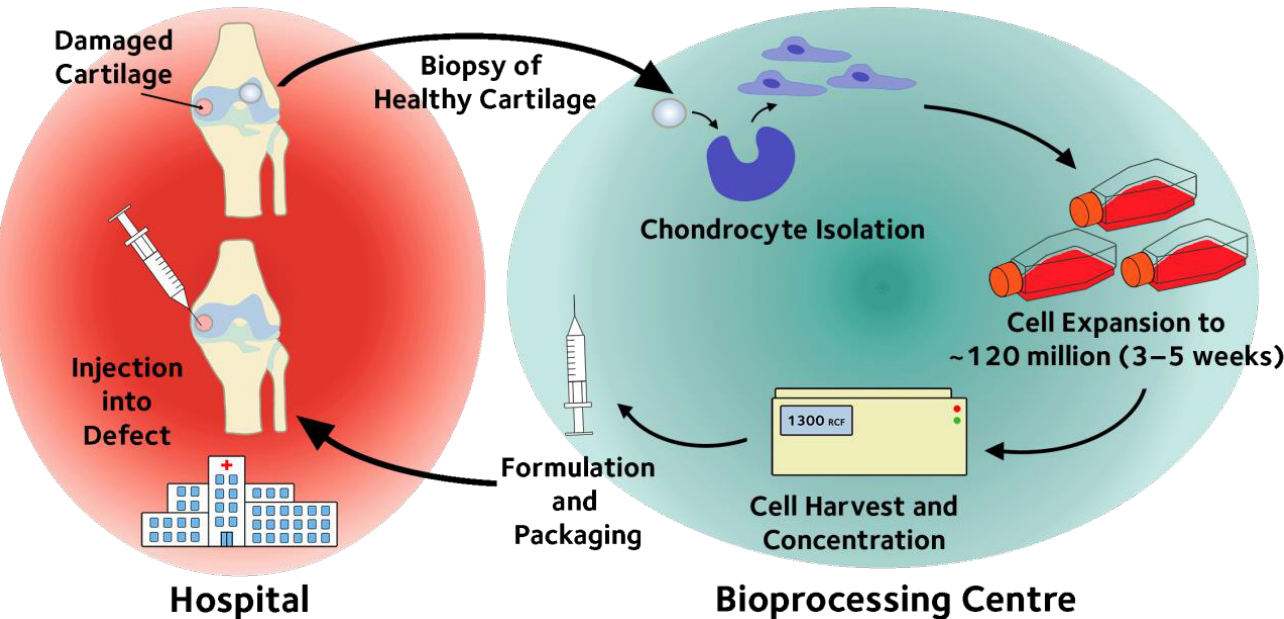
Figure 1. The processing steps of the approved ACI procedures based on the commercial process [5].